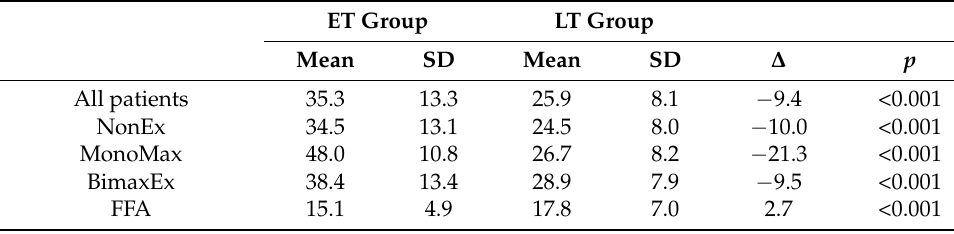
Table 7. Duration in months (Mos) of active